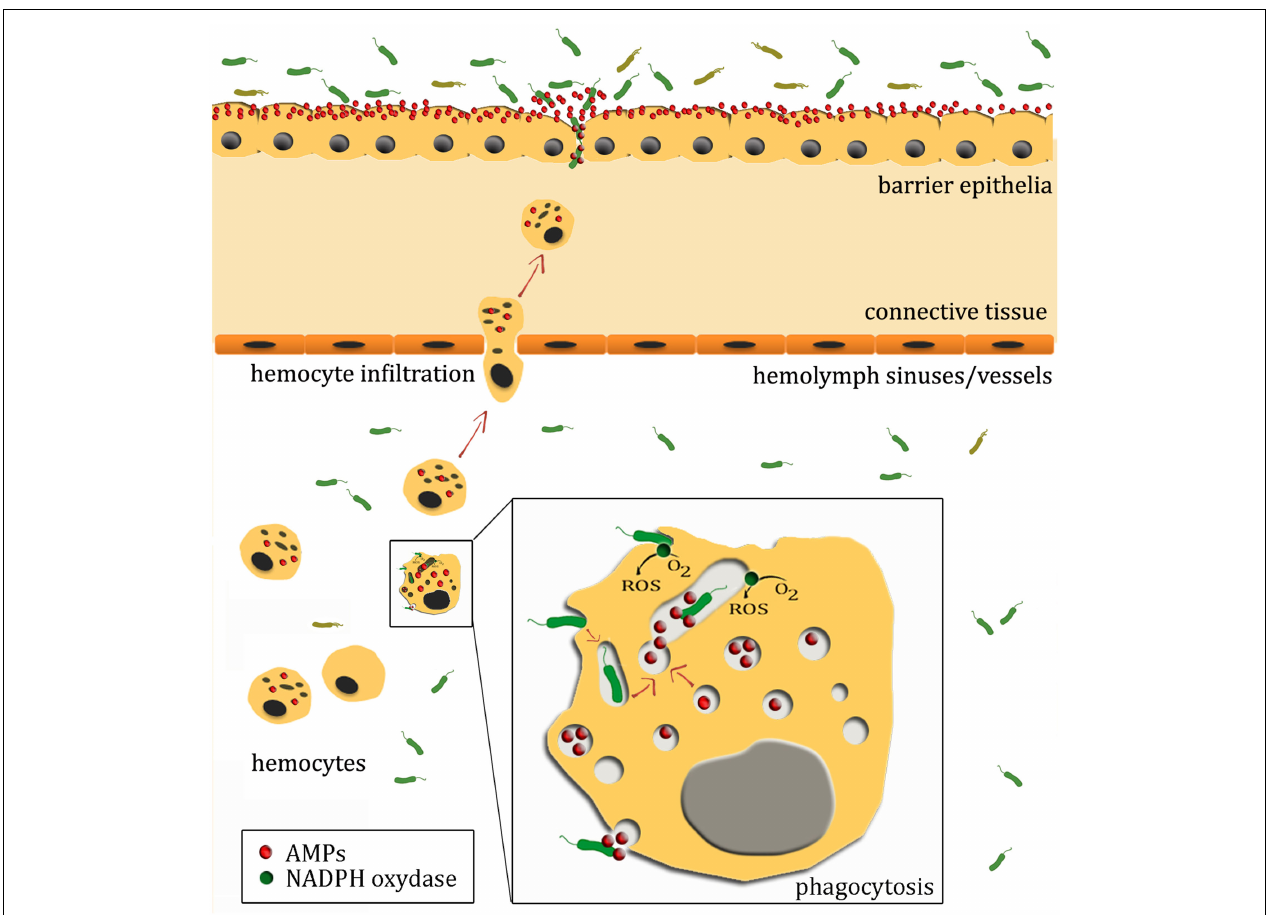
Infiltrating hemocytes serve as vehicles for AMP families that display synergistic activities with AMPs from epithelial surfaces. Upon recognition by pattern recognition receptors/proteins, microorganisms present in tissues and hemolymph can also be phagocytosed and further eliminated by the production of reactive oxygen species (ROS), hydrolytic enzymes, and AMPs. It is still unknown whether AMP-containing hemocyte granules fuse with the phagosome, undergo exocytosis or